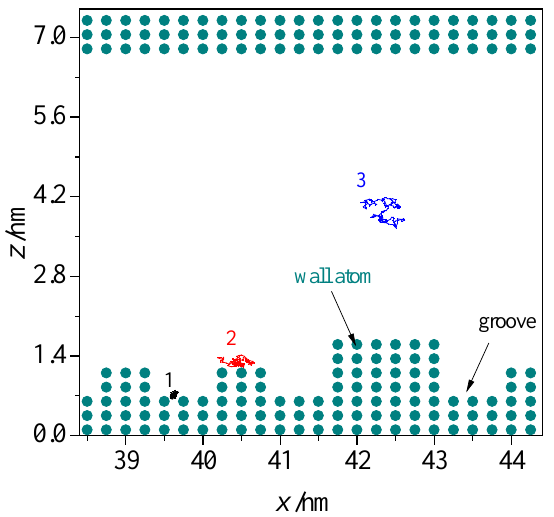
Figure 8. Motion trajectory of fluid atoms in a rough nanochannel.